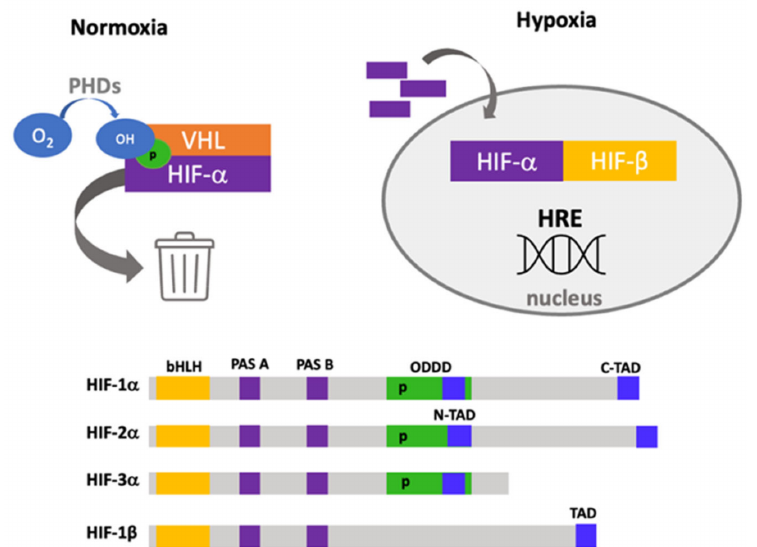
Figure 1. Hypoxia adaptation by HIF system. Hydroxylation reactions in proline residues of alpha subunits (HIF-1 α , HIF-2 α and HIF-3 α ) depend on available oxygen (normoxia); these reactions cause its degradation by interaction with Von Hippel Lindau protein (VHL). The decrease in oxygen concentration inhibits HIF- α hydroxylation and induces its accumulation in the cytoplasm and subsequent translocation to the nucleus, where it heterodimerizes with the HIF-1 β (hypoxia). This heterodimer is able to bind to hypoxia response elements (HRE) found in promoters of diverse genes. Structure and functional domains of hypoxia-inducible factors